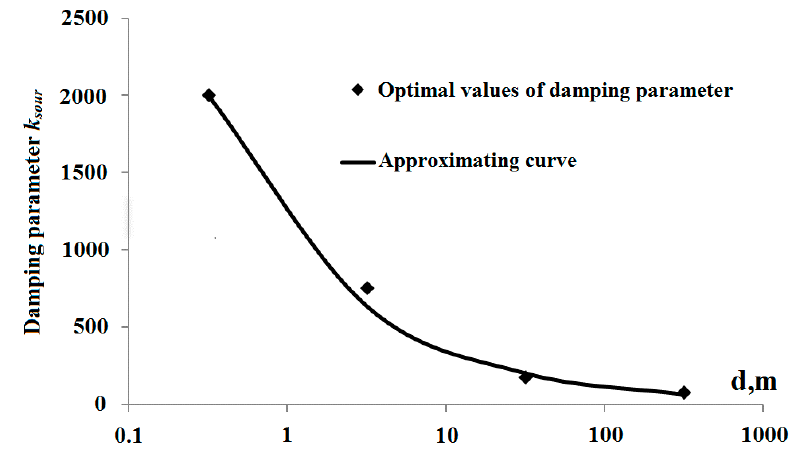
Figure 3. Damping parameter k sour as a function of the channel depth.